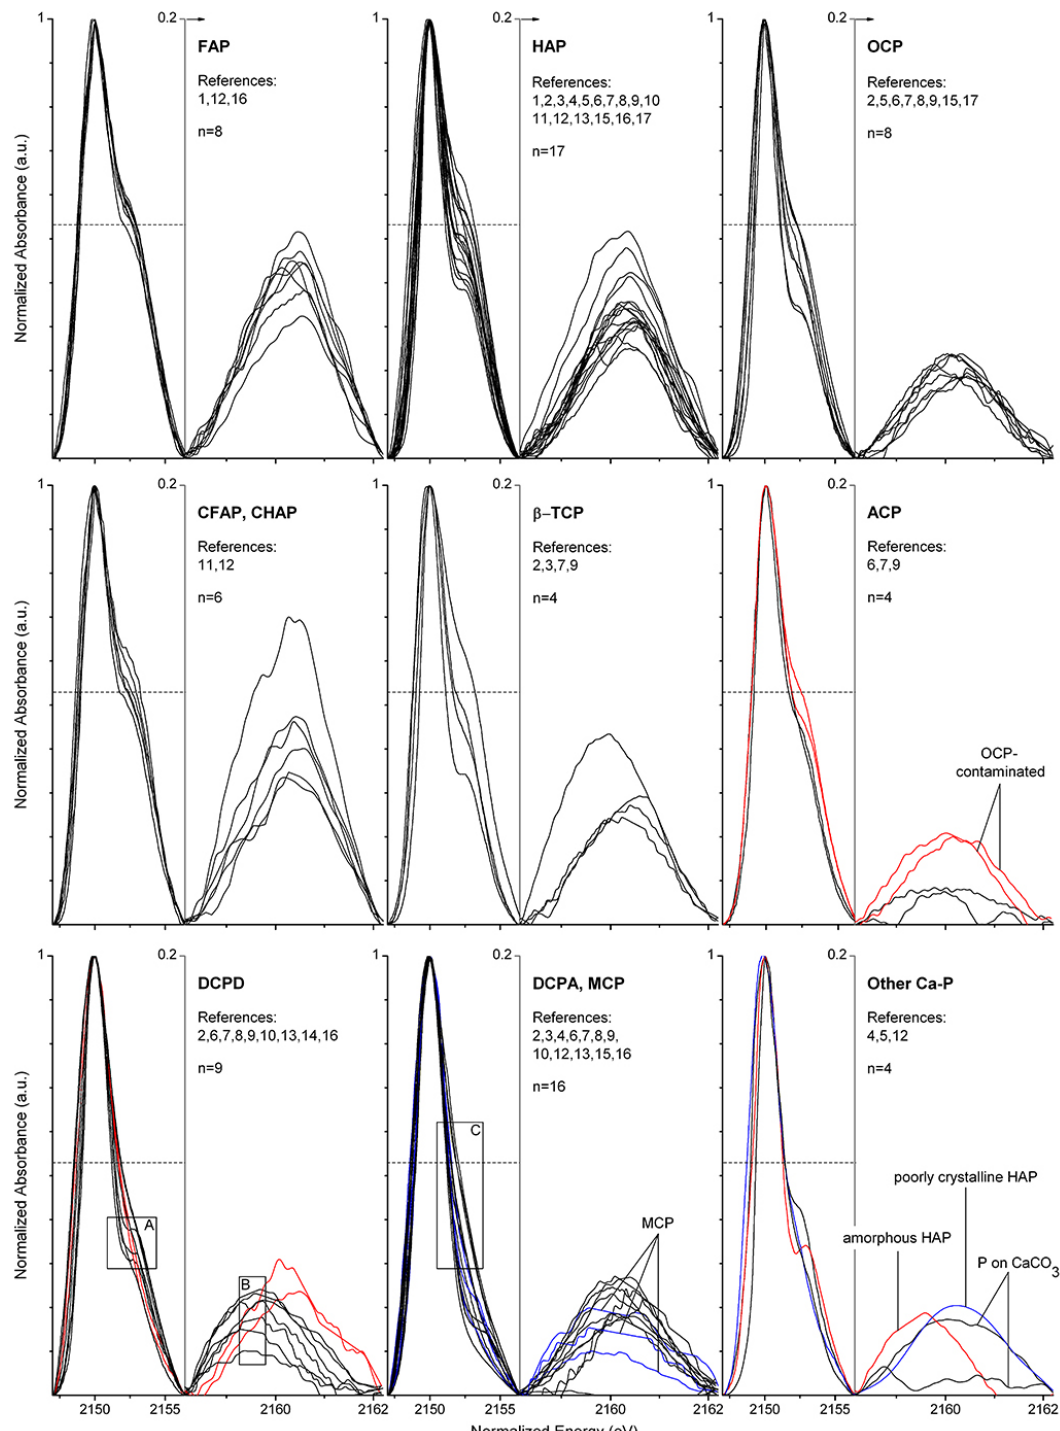
Fig. 3. Species-specific XANES fingerprints of 74 Ca-P reference compounds identified by normalized secondary peak positions and heights. Secondary peak heights are given as arbitrary units relative to maximum main peak intensities of one. Two ACPs likely contained OCP (red curves; text). DCPDs generally showed OCP-like secondary peak heights but their secondary peak positions were at lower energies (B). Two DCPDs with secondary peaks at higher energies (red curves; text) lack OCP-like post-edge shoulders (A). Secondary peaks of DCPAs and MCPs are comparable to those of OCPs, but their main peaks always lack typical post-edge shoulders (C). Reference numbers refer to detailed information in Table 1. Dotted lines indicate the average post-edge shoulder height of apatite ( n =